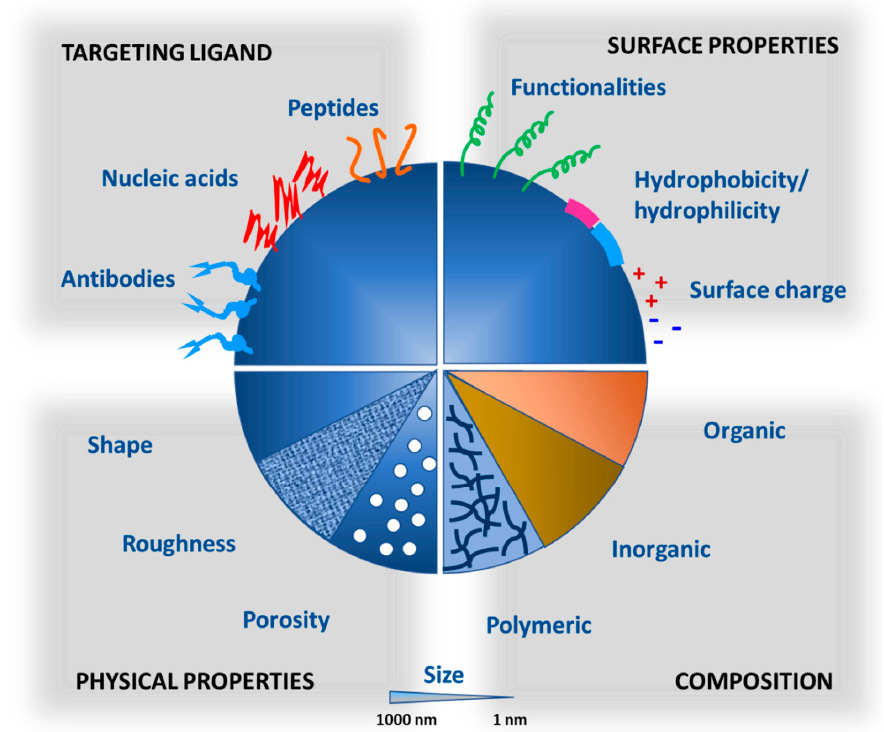
Figure 4. Biological and physicochemical properties of nanocarriers in modulating biopharmaceutical delivery.